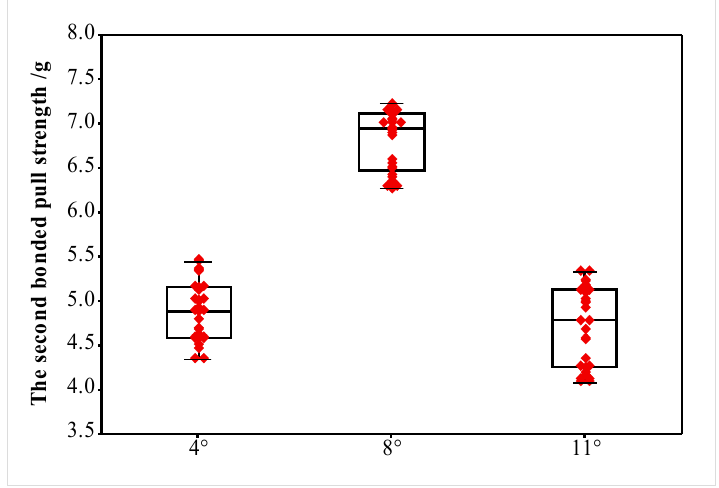
Figure 15. The pull strength of the second bonded point alloy wire when the WFA is 4°, 8° and 11°.